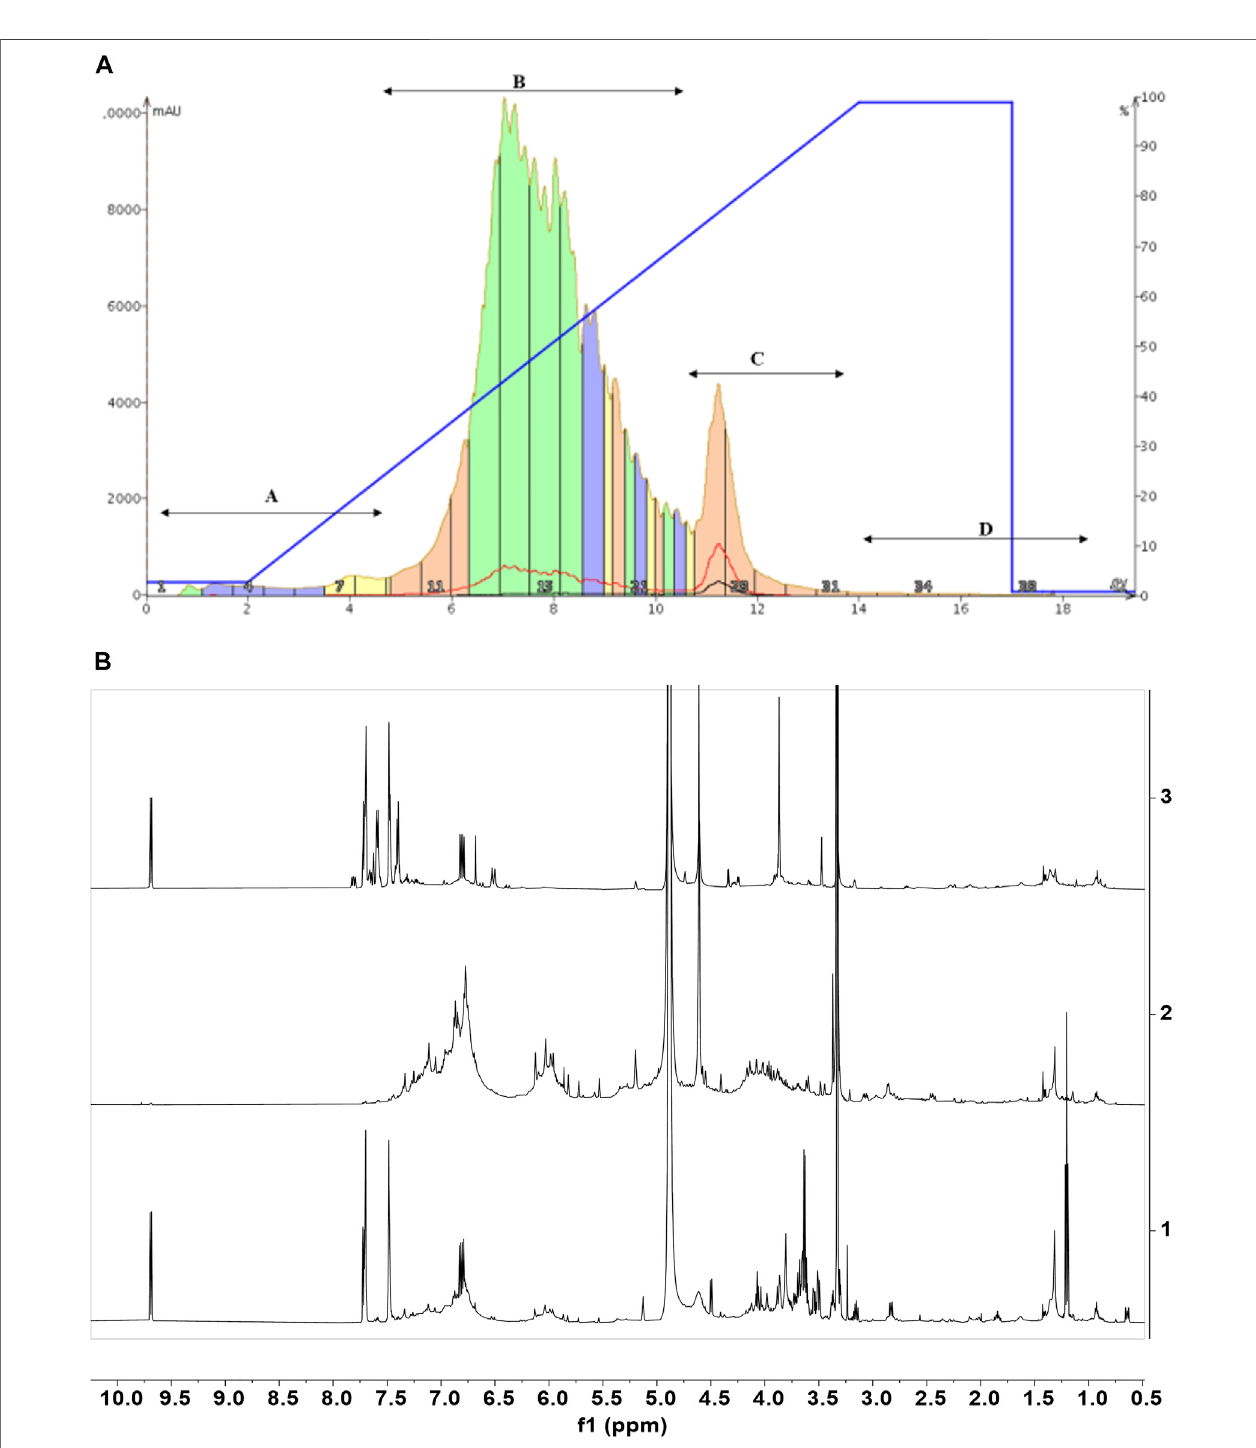
FIGURE 5 | Cinnamon extracts ’ fractionation. Chromatographic pro fi le (A) of the separation of CCHE extract obtained by reverse phase C18 chromatography (linear elution gradient from 2% to 100% MeOH in 15 CV). (B) The 1 H-NMR spectra of the chromatographic fractions B (2) and C (3) compared to the 1 H-NMR pro fi le of the total extract (1). 1 H-NMR spectra were recorded on 5 mg/ml samples dissolved in CD 3 OD, 25 ° C, at 600 MHz.